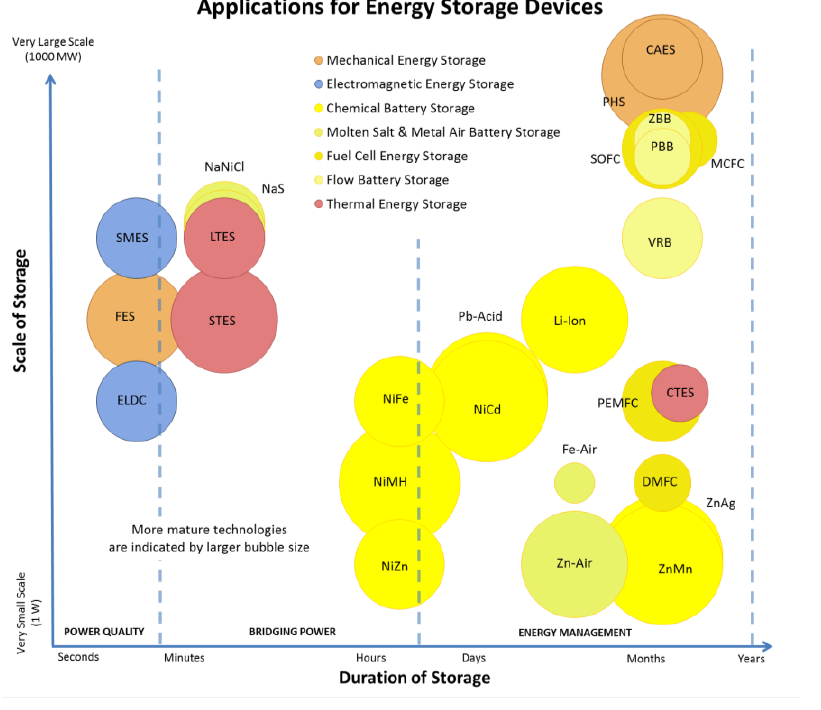
Figure 16. A rough breakdown of the specific applications for which storage technologies are suited. Detailed sub-divisions of these applications are provided in Tables 1 and 2. For fuel cells hydrogen storage is assumed. Larger bubbles indicate more mature